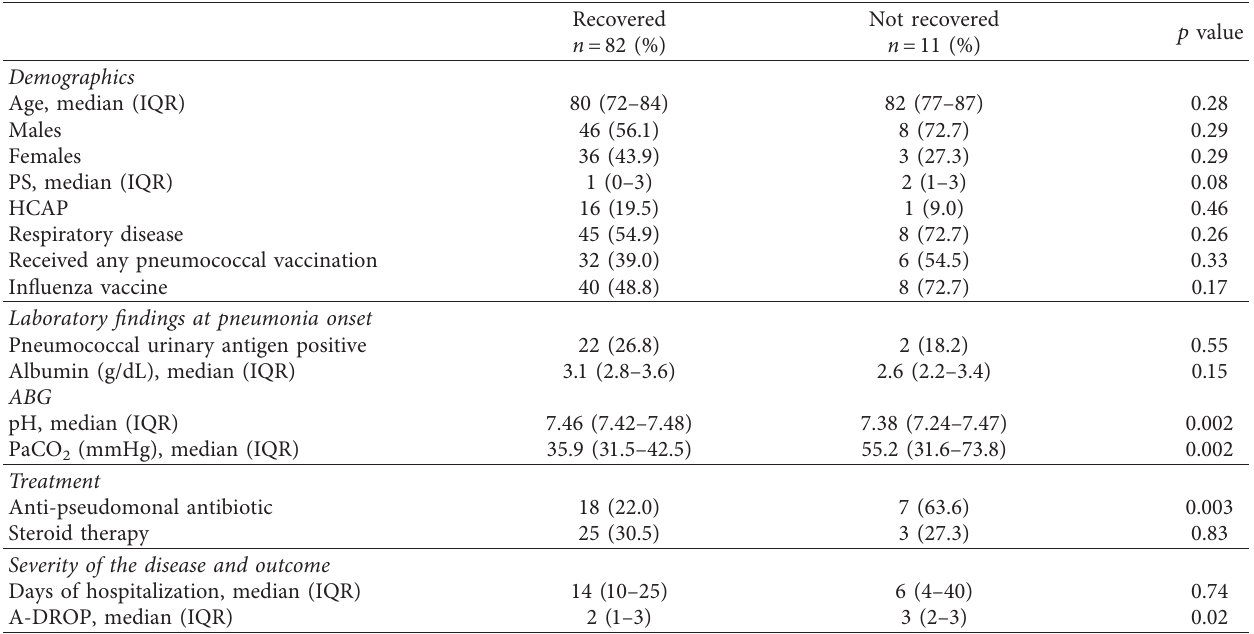
Table 3: Univariate analysis of risk factors for